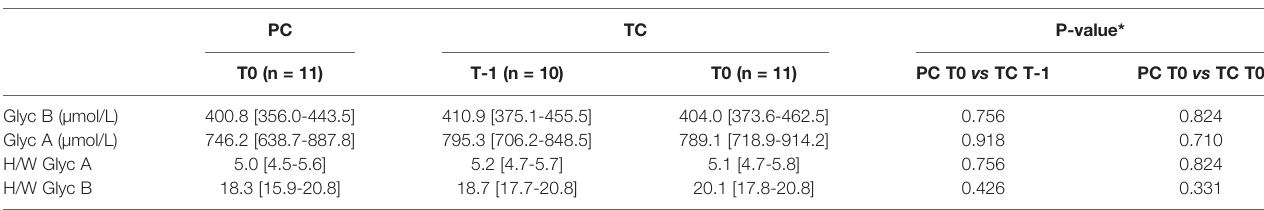
TABLE 2 | Plasma glycoprotein analysis in